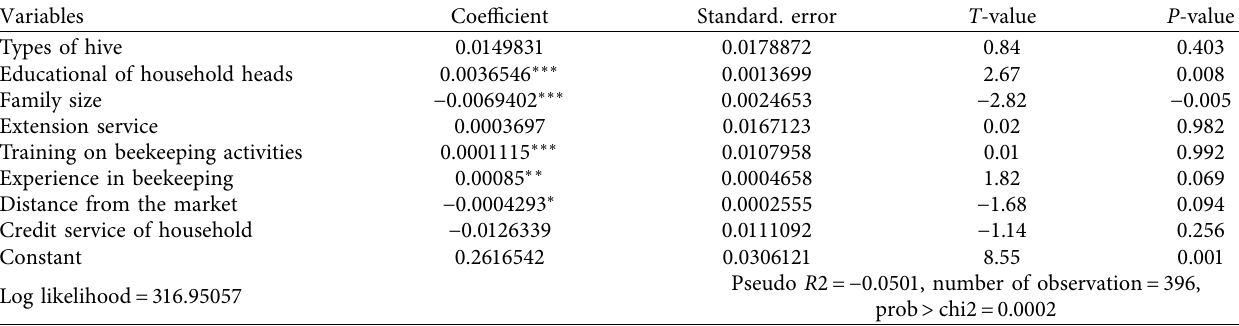
Figure 2: Ranges of economic efciency in honey production. Source: computed from the model result. Table 5: Tobit model result for determinants of economic